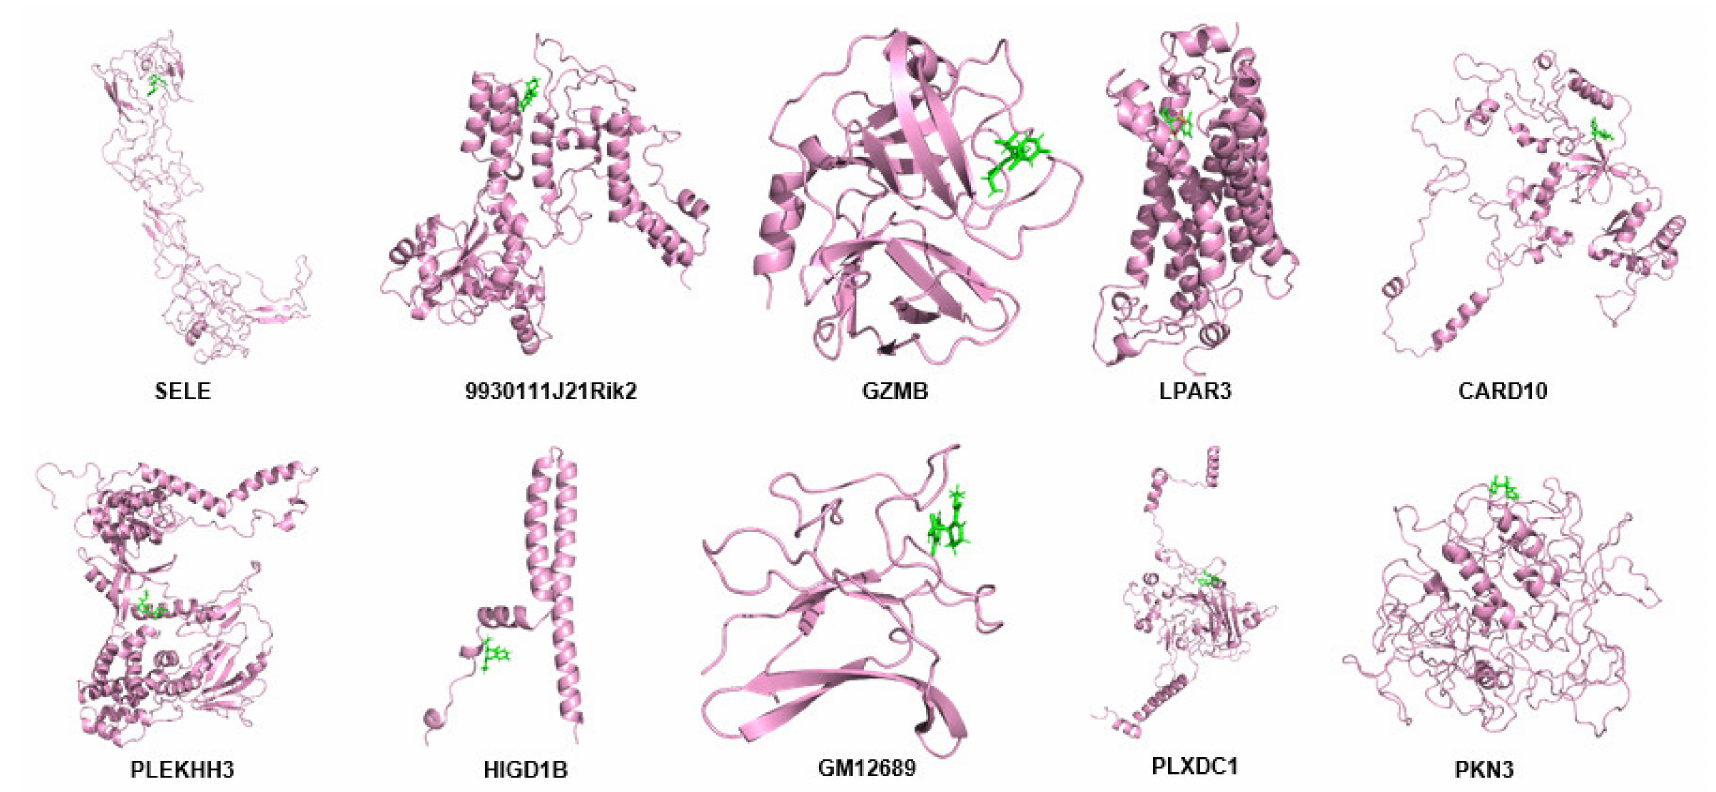
Figure 17. The 3-D view of TAK 242-hub proteins. The three-dimensional view of the TAK242-protein complex was demonstrated, including SELE, 9930111J21RIK2, GZMB, LPAR3, CARD10, PLEKHH3, HIGD1B, GM12689, PLXDC1, and PKN3. TAK 242 was colored in green. Figures were generated by using the Pymol